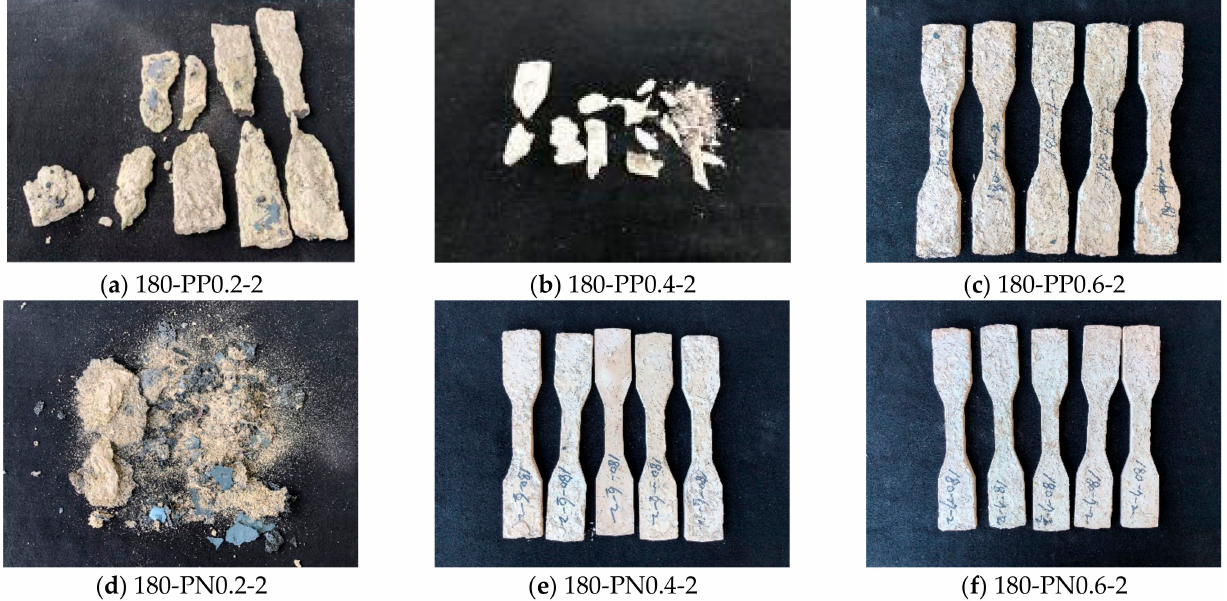
Figure 4. Appearance of the 180 MPa specimens after 2 h of fire